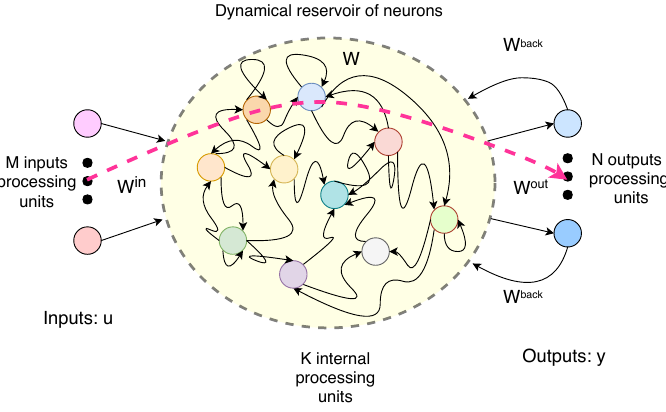
Figure 1. A simplified representation of the ESN